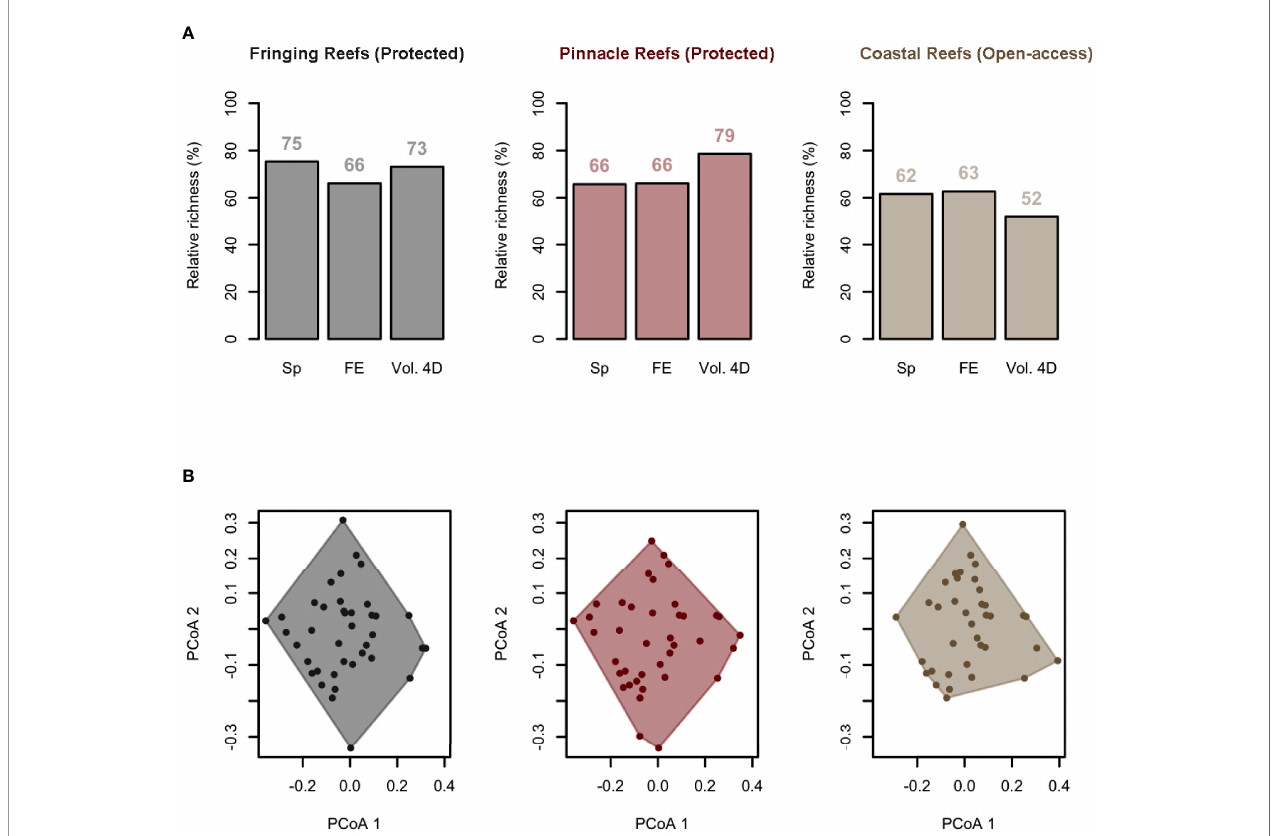
FIGURE 7 | Functional space fi lled by fi sh communities in areas with Fringing Reefs — Protected (gray), areas with Pinnacles Reefs — Protected (red), and Open Access areas to fi sheries (beige). Species and functional diversity changes among zones with different zones. (A) Barplots show species richness (Sp), number of functional entities (unique trait combinations, FE), and functional richness, i.e., the volume fi lled by each assemblage in the four dimensions of the functional space (Vol. 4D). Values are expressed as a relative percentage of the value for the total pool and are displayed above the bars. (B) Functional space fi lled by the functional entities (FEs) present in species assemblages from each pH condition. Axes (PCoA1 and PCoA2) represent the fi rst two dimensions of the 4D functional space. Principal coordinate analysis (PCoA) was computed on functional-trait